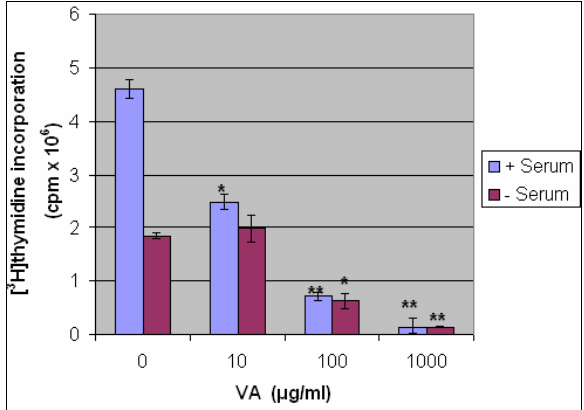
Figure 3: Inhibition of DNA synthesis by VA extracts in the presence and absence of serum . For DNA synthesis in the presence of serum, cells at logarithmic growth phase were treated with various (0 – 1000 µg/ml) VA for 18 h followed 6 h treatment of 1 µCi/ml [ 3